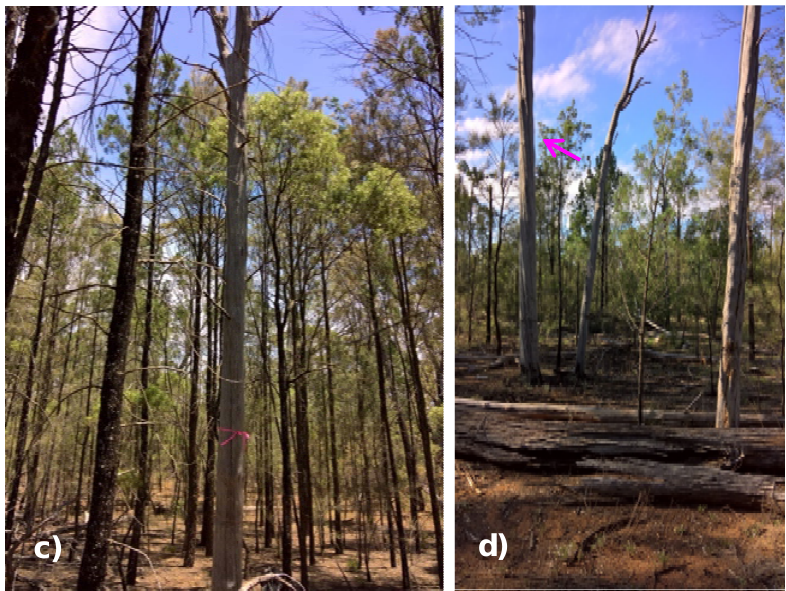
Figure 5. Photographs illustrating the density of small stems (<10 cm DBHOB) in ( a ) unthinned control sites, ( b ) thinned sites, ( c ) areas around roost trees used by N. corbeni and N. gouldi and ( d ) areas around roost trees used by N. geoffroyi and V. vulturnus located in thinned sites. Pink flagging tape (c) and the arrow (d) indicate the roost tree.